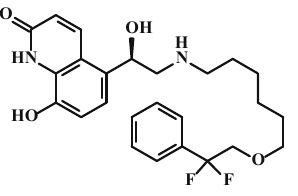
Figure 10: Chemical structure of clenbuterol.